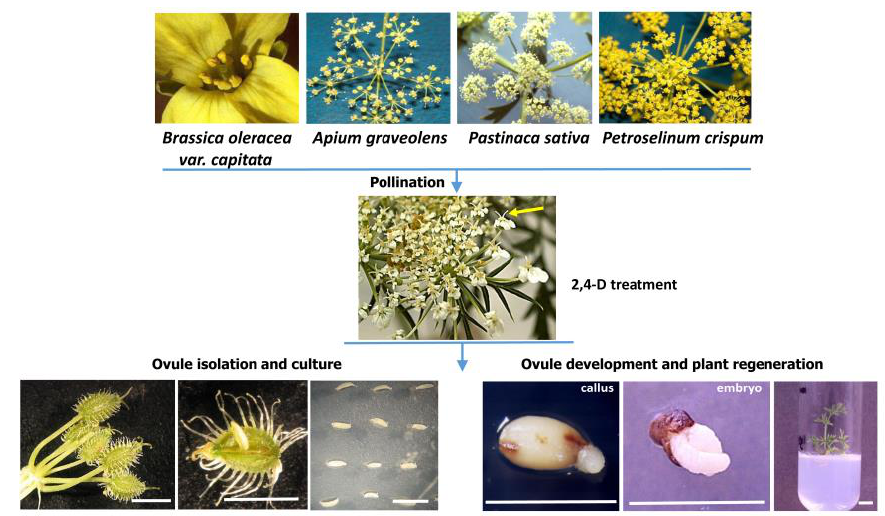
Figure 6. Flowchart of the experiment on the development of the carrot ovules isolated from the flowers pollinated with foreign pollen. Blue arrows indicate the transition between the steps. Description of figures from top to bottom: Flowers and inflorescences of pollen donors; Close-up image of the carrot inflorescence showing flowers in the receptive stage (the yellow arrow indicates that the styles have separated from each other, forming a V-shape); Ovule isolation and culture: enlarged carrot ovaries before ovule isolation, ovule excised from the ovary, ovules placed onto culture medium; Ovule development and plant regeneration: callus tissue developing at the micropylar region of the ovule, embryo emerging from the ovule, regenerated plantlet. Scale bar 0.5 cm.